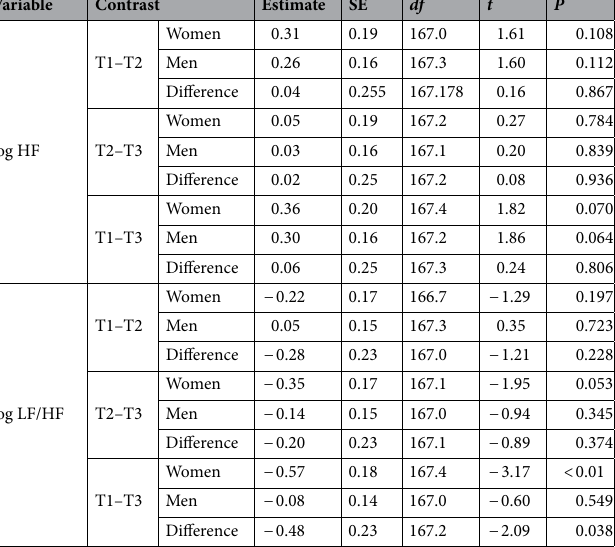
Table 5. Contrasts assessing changes between trimesters.Note: SE, standard error; df, degrees of freedom, t , t-statistic for parameter estimate; P , p value.